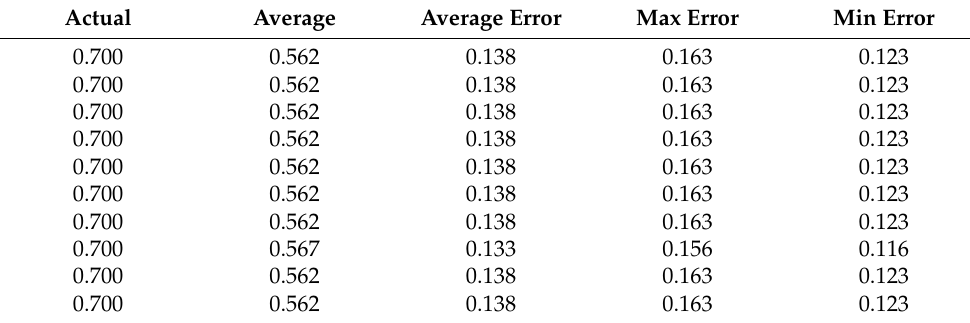
Table A203. Set 3, trials 31–40 data (all 0.5 PR values).